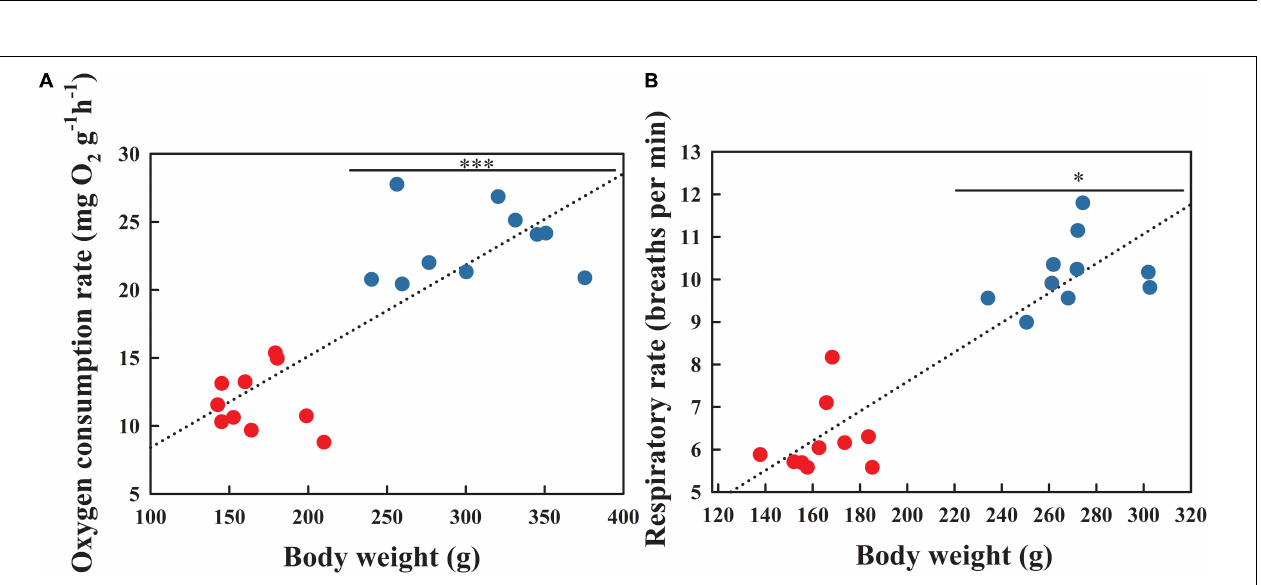
FIGURE 2 | Oxygen consumption rate (A) and respiratory rate (B) of A. japonicus at different breeding stages. Asterisk indicates a significant difference between the non-breeding stage (NBS, red points) and the breeding stage (BS, blue points). ∗∗∗ P < 0.001; ∗ P < 0.05.